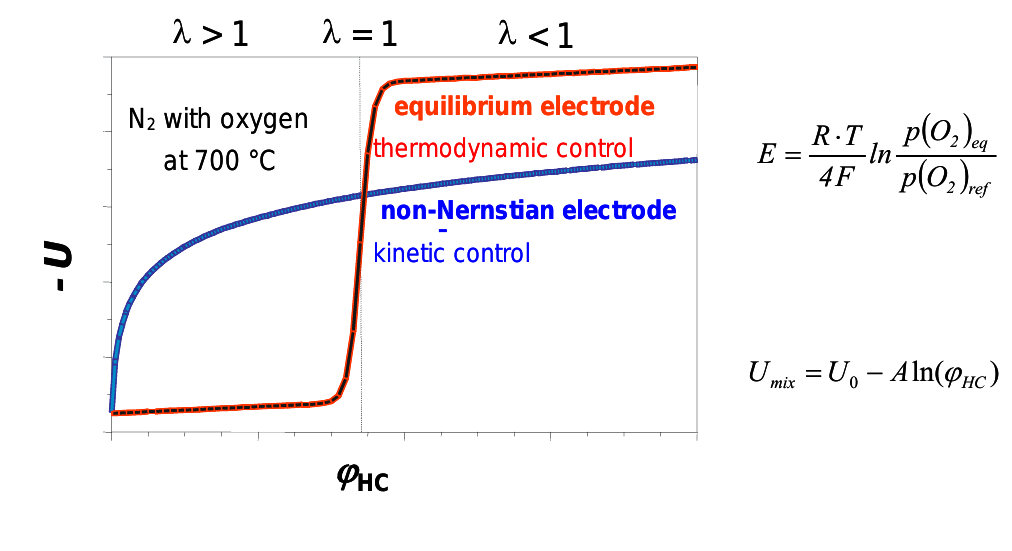
Figure 2. Scheme of the voltage characteristics of an idealized hydrocarbon electrode